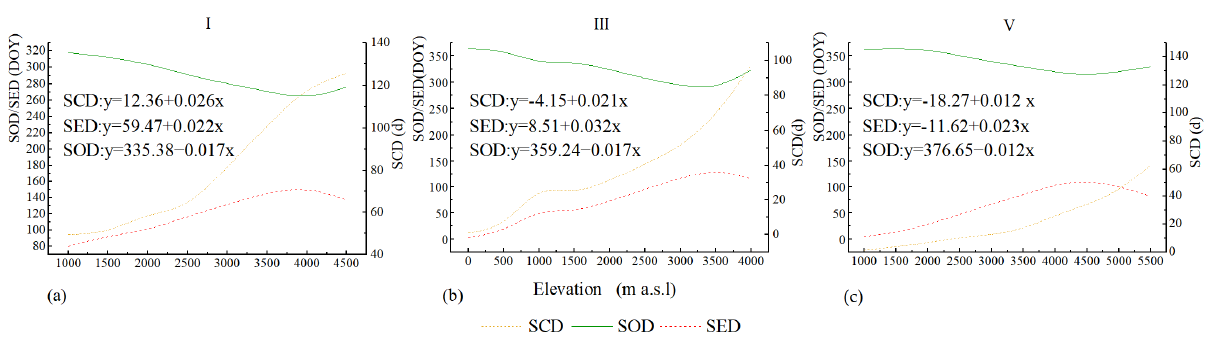
Figure 6. Variations of snow cover phenology with elevation in different subdivisions: ( a ) Altai Mountains; ( b ) Tienshan Mountains; ( c ) Kunlun Mountains. Mountains; ( b ) Tienshan Mountains; ( c ) Kunlun